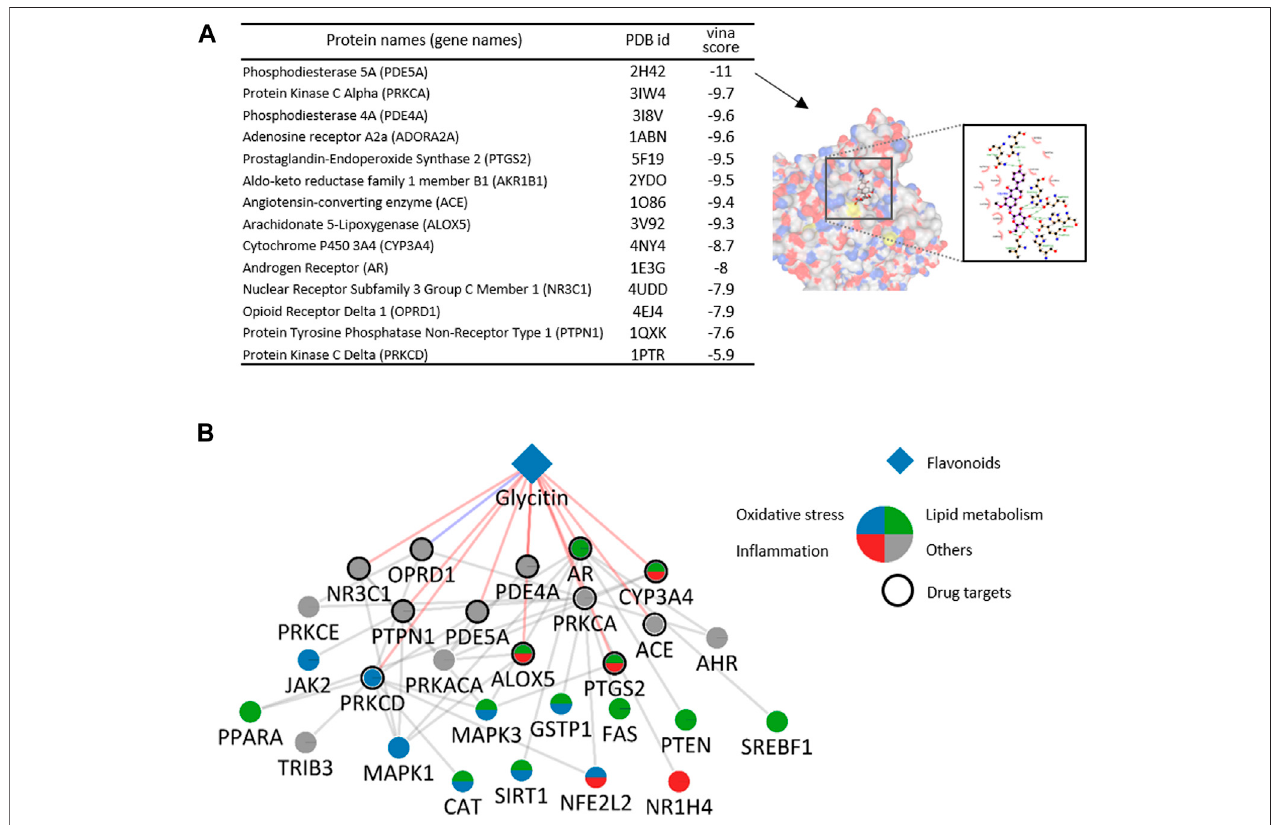
FIGURE 6 | Molecular docking validation and potential mechanism of glycitin. (A) Molecular docking results between glycitin and its predicted target and its representative example. (B) Discovered target-NAFLD associated protein network for glycitin. A diamond denotes a fl avonoid and circles denote protein targets. The border and color of the circle denote the predicted target or related process-level function,